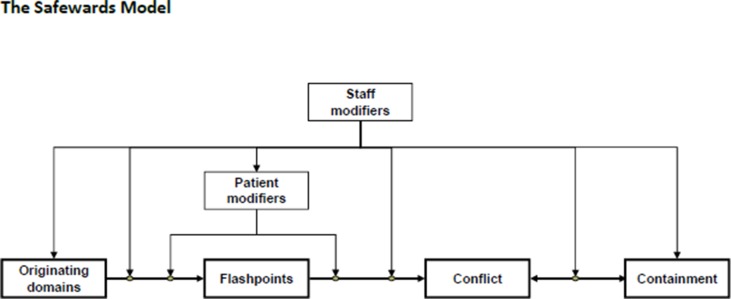
Simple form Safewards Model (16, p. 500).